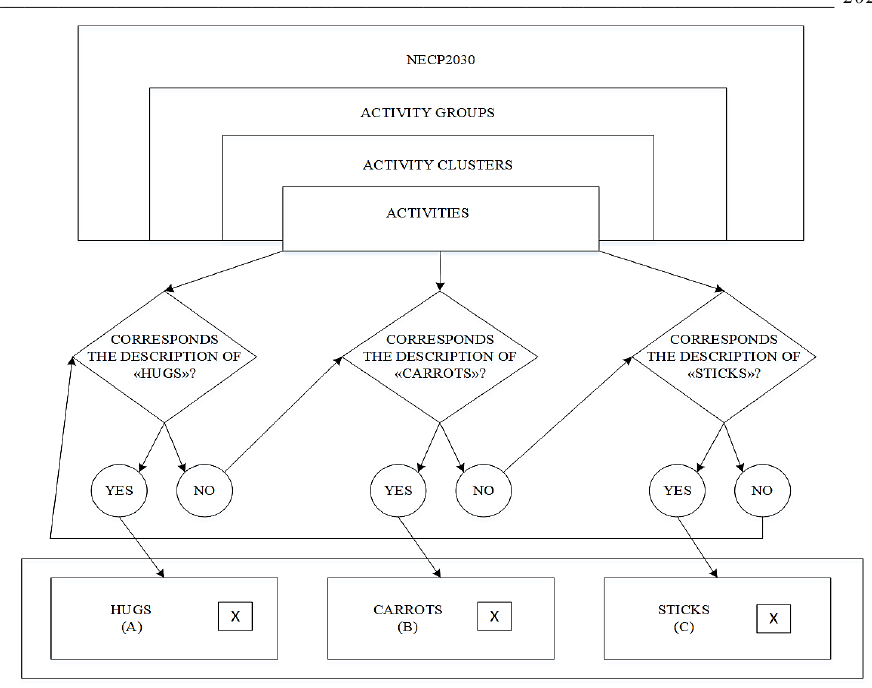
Fig. 2. Identification of the type of activity (authors’ own